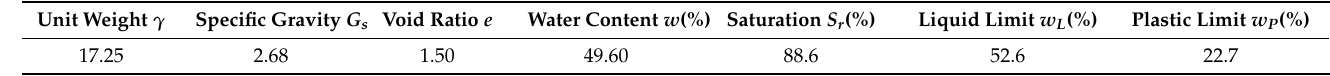
Table 1. Physical parameters of the original